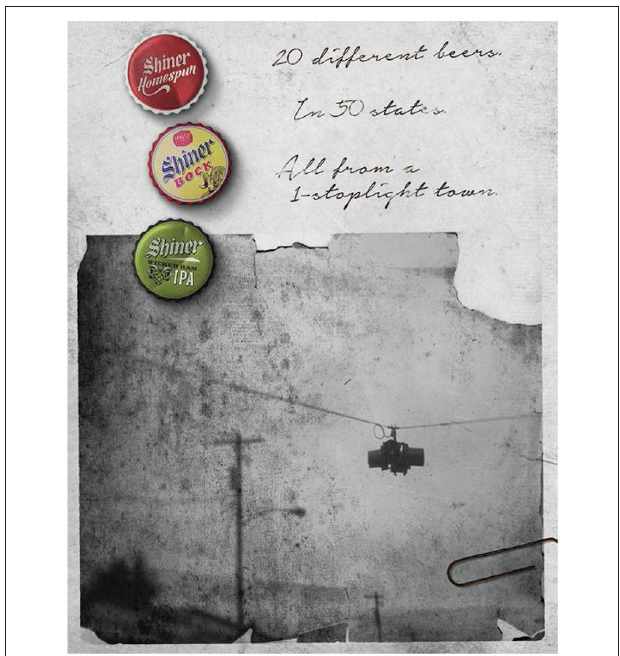
FIGURE 7 | Example 3: Shiner Bock, Minneapolis (USA), in-house, Lürzer’s Archive 1/2019: 35.